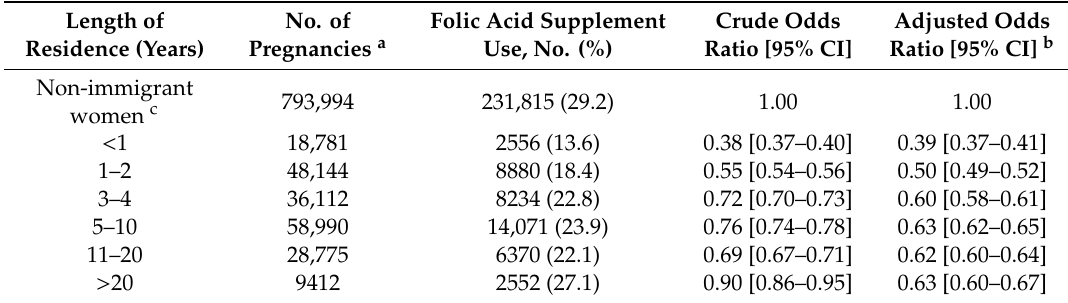
Table 3. Percentages and odds ratios for preconception folic acid supplement use by maternal length of residence among 1st generation immigrant women